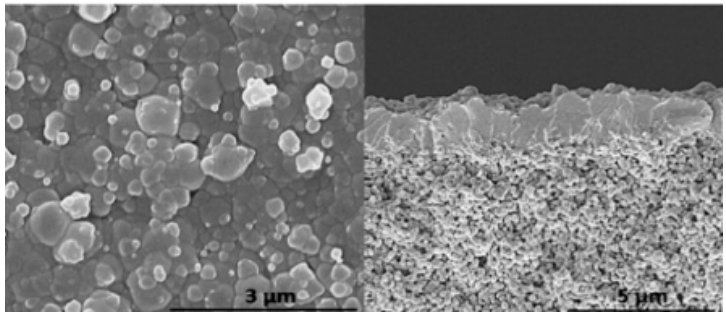
Figure 15. Schematic diagram for the automated layer-by-layer (LBL) growth of MOFs thin films on substrates functionalized with self-assembled monolayers (SAMs). The preparation is done by repeated immersion cycles first in a solution of the metal precursor and subsequently in the organic ligand solution, with solvent rinsing in-between (adapted with permission from ref. [53]).